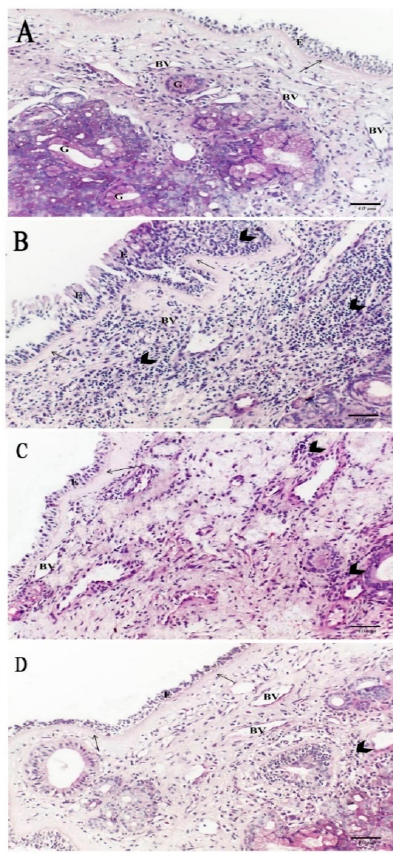
Figure 5. ( A ) A photomicrograph of a section in the nasal mucosa of group I (control group) displaying normal nasal mucosa with respiratory epithelium (E) resting on thin basal lamina (arrow) and lamina propria of loose connective tissue having multiple blood vessels (BV) and seromucinous glands (G). ( B ) A photomicrograph of a section in the nasal mucosa of AR group (Group II)